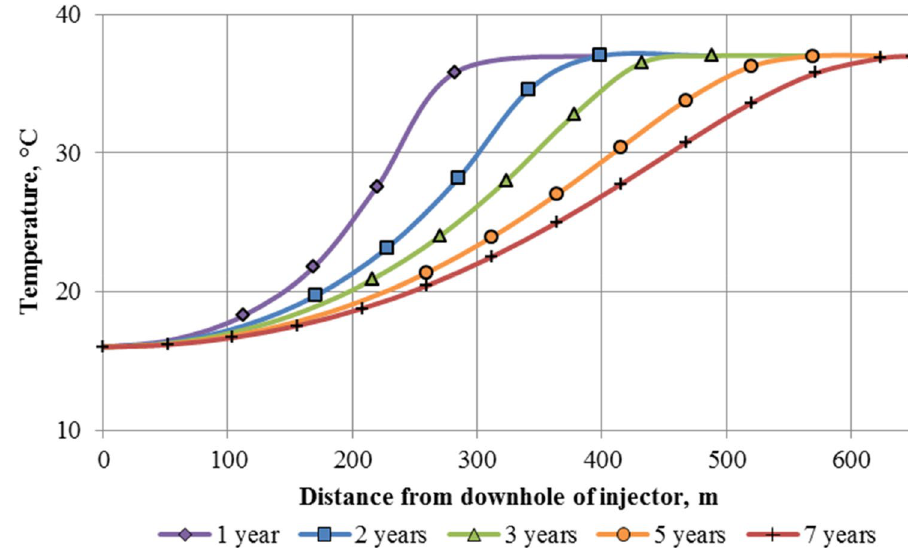
Fig. 9 The calculated tempera- ture field in the near-wellbore area of the injection well